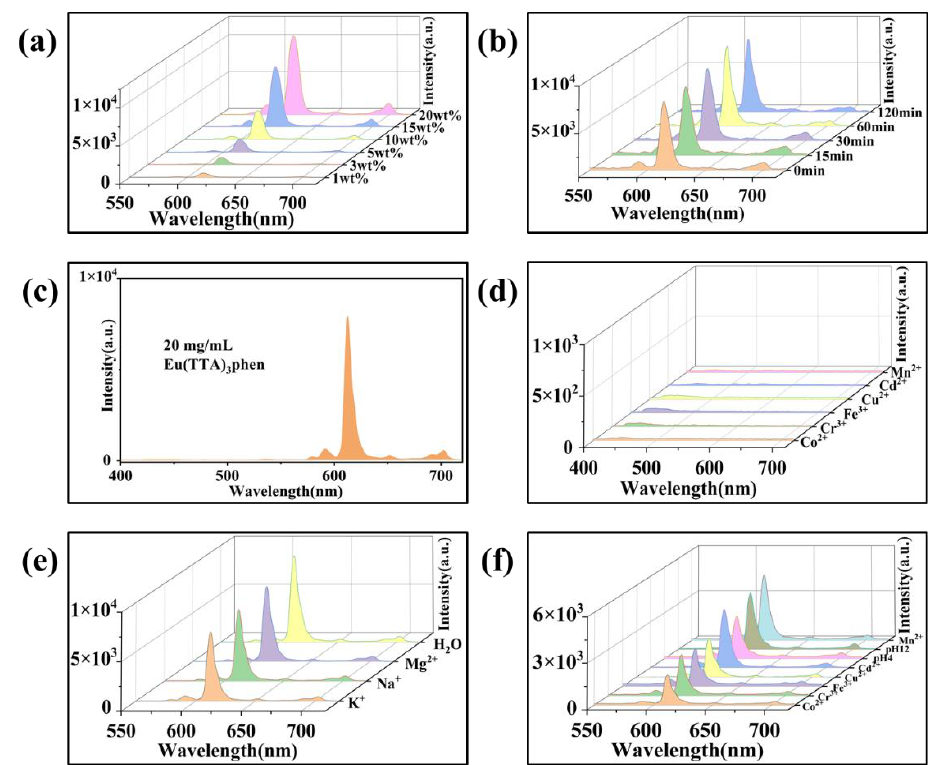
Figure 8. ( a ) Emission spectra of E-uMWCNT-Fs with different contents of Eu(TTA) 3 phen; ( b ) Emission spectra of E-uMWCNT-Fs after soaking in H 2 O for different times; ( c ) Emission spectrum of 20 mg/mL Eu(TTA) 3 phen; ( d ) Emission spectra of 20 mg/mL Eu(TTA) 3 phen after soaking in 0.01 M heavy-metal-ion solution for 10 min; ( e ) Emission spectra of E-uMWCNT-Fs after soaking in 0.1 M non-heavy-metal-ion solution for 1 h; ( f ) Emission spectra of E-uMWCNT-Fs after soaking in 0.01 M heavy-metal-ion solution and pH 4~12 aqueous solutions for 1 h. (Results shown in ( b , d – f ) were measured with a 15 wt% E-uMWCNT-F sample).